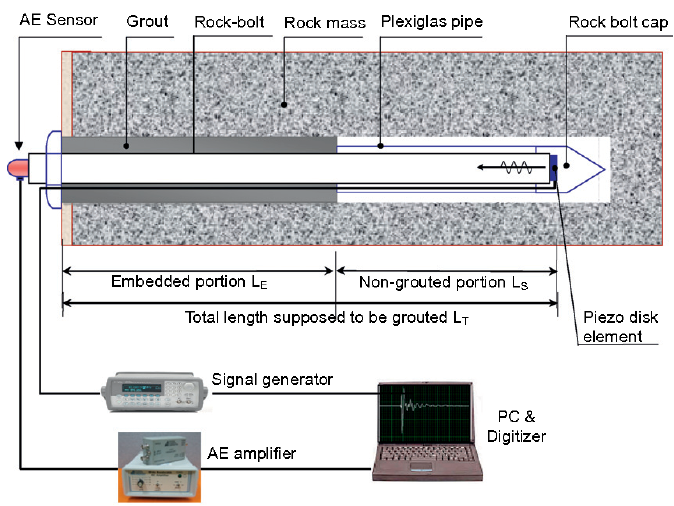
Figure 1. Rock bolt integrity measurement system [13].